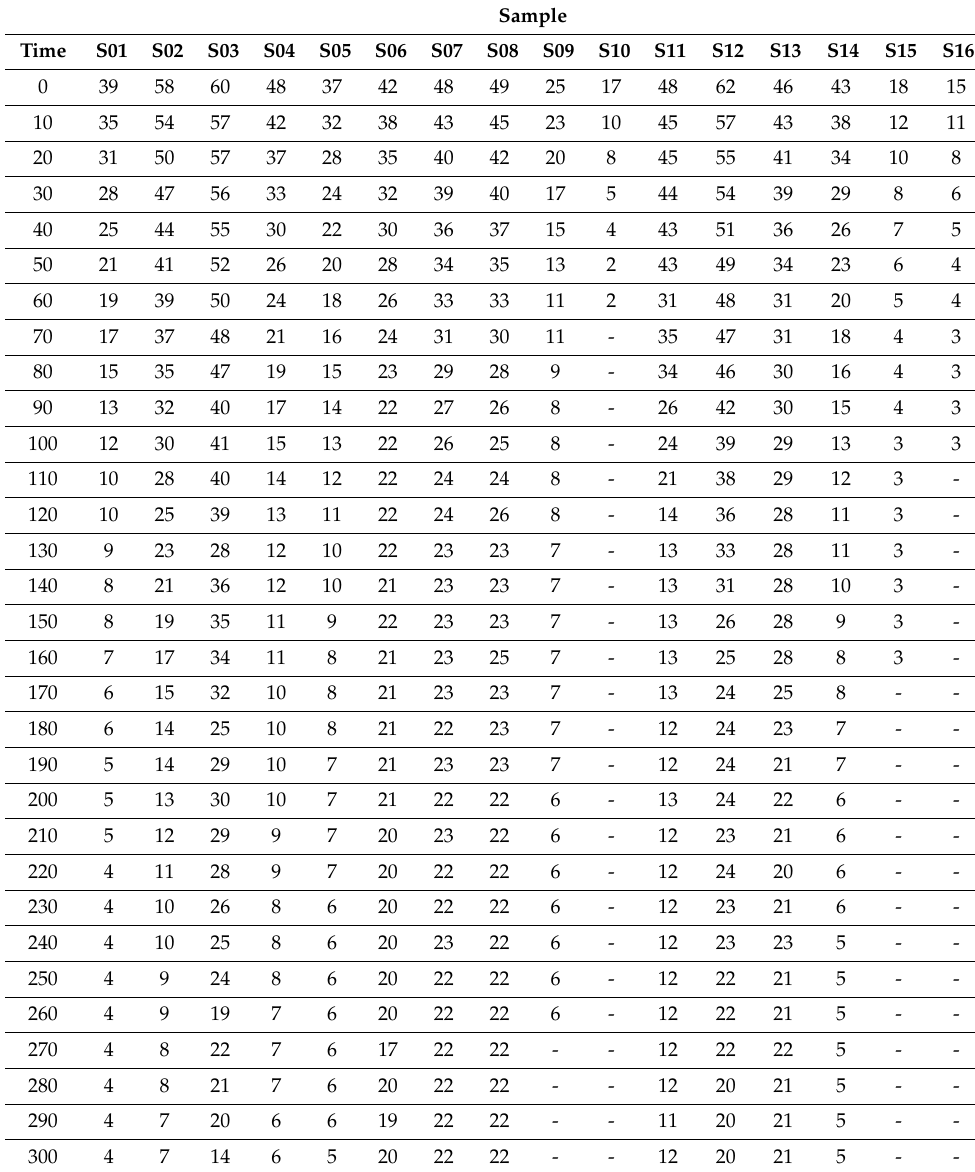
Table 2. Height (mm) of foam determined by performing image analysis on RGB videos of 16 beer